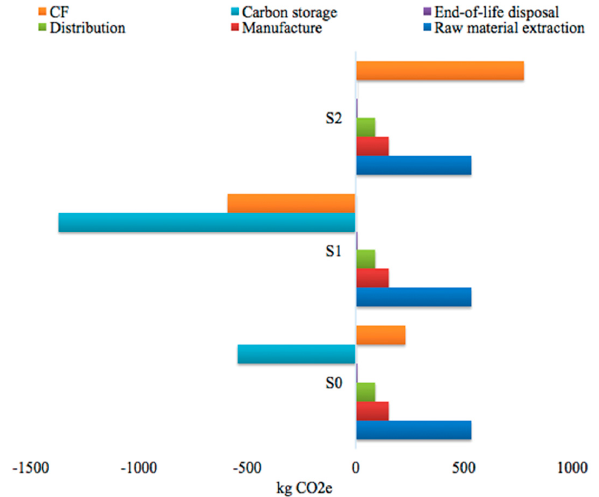
Figure 5. Carbon footprint of MDF quantified by PAS 2050 (cradle-to-grave assessment). S0: scenario 0; S1: scenario 1; S2: scenario 2.